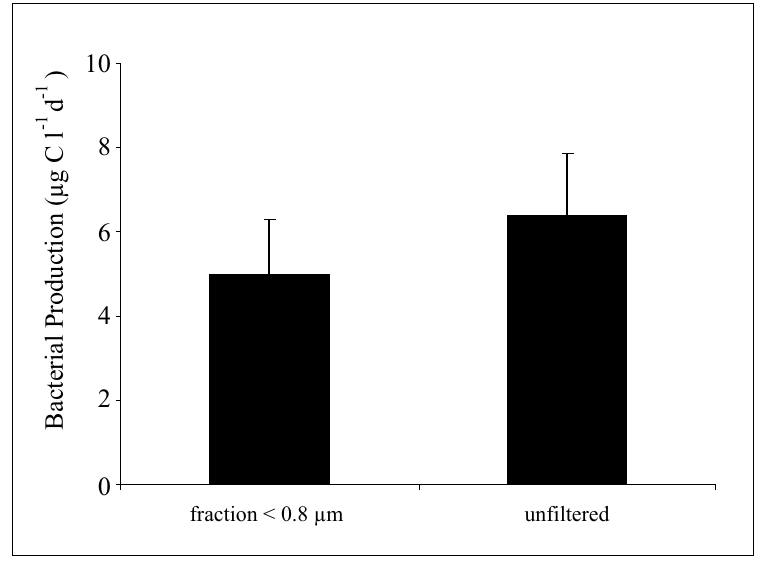
Fig. 3 – Bacterial production in water samples from Lake Stechlin at < 0 . 8 µ m and unfiltered sample. Vertical bars represent the average (n=5) + standard deviation.